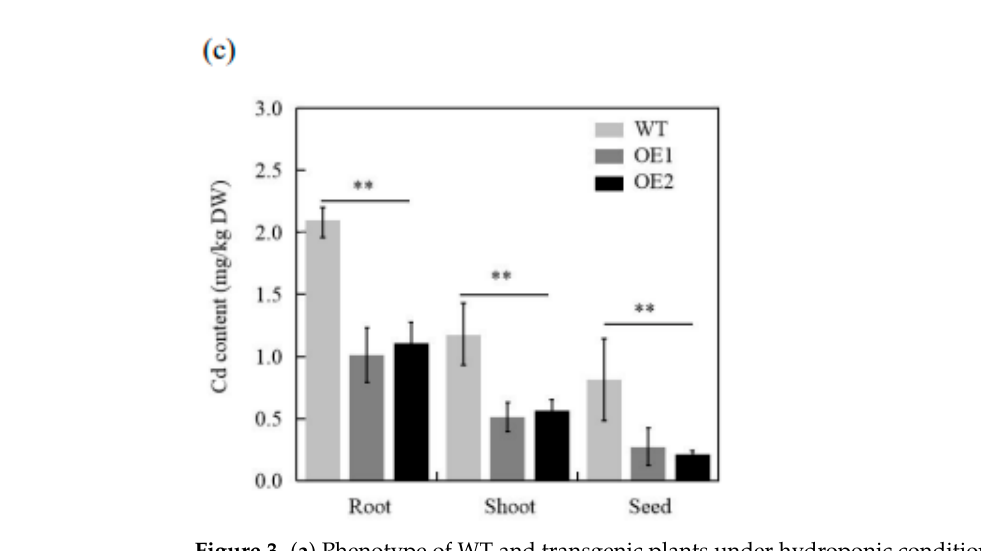
Figure 3. ( a ) Phenotype of WT and transgenic plants under hydroponic conditions. ( b ) Phenotype of WT and transgenic plants under pot conditions. ( c ) Cd concentration in roots, shoots, and grains of the WT and transgenic plants. ** Significant differences at p ≤ 0.01.